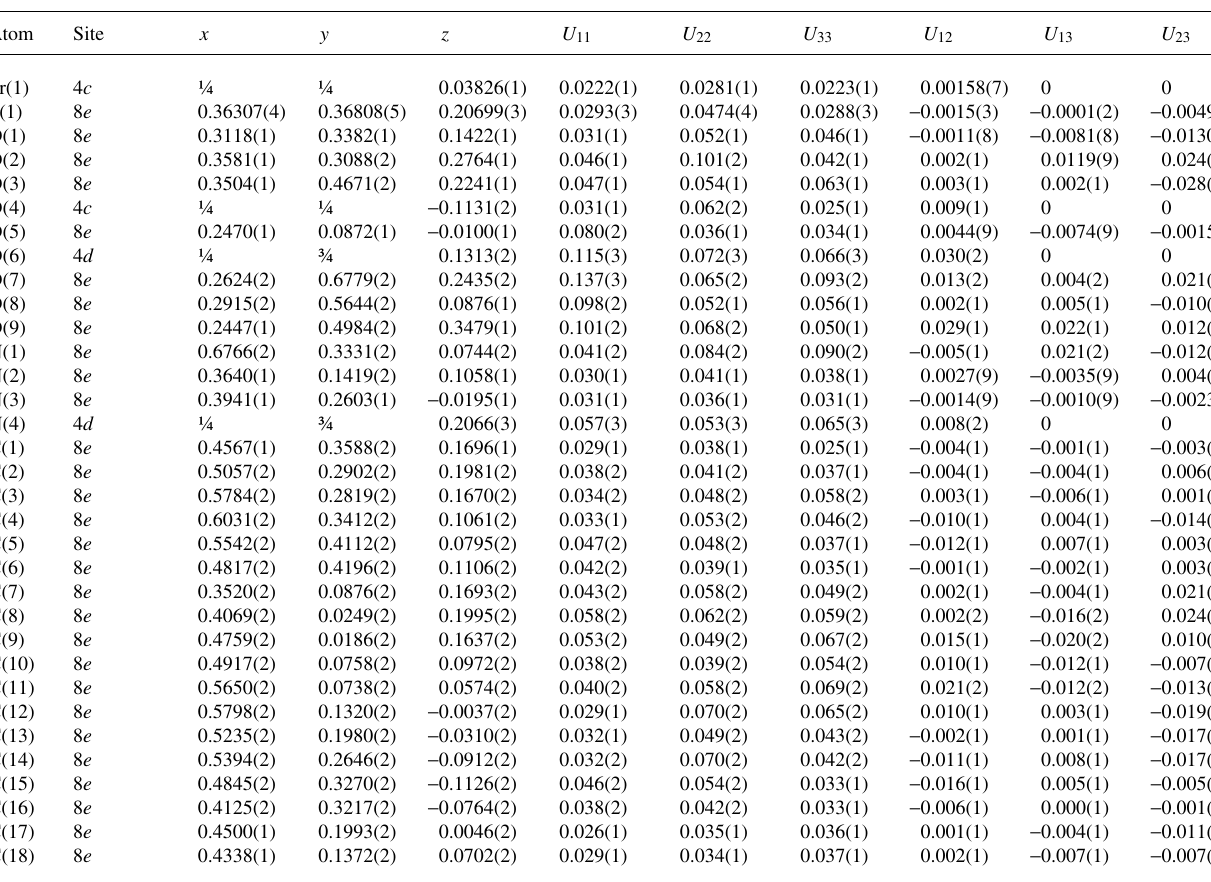
Table 3. Atomic coordinates and displacement parameters (in Å 2 ) .